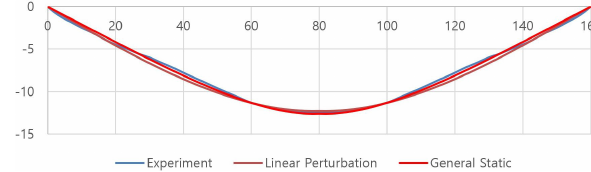
Figure 18: Comparison of bending deformation values on laminate